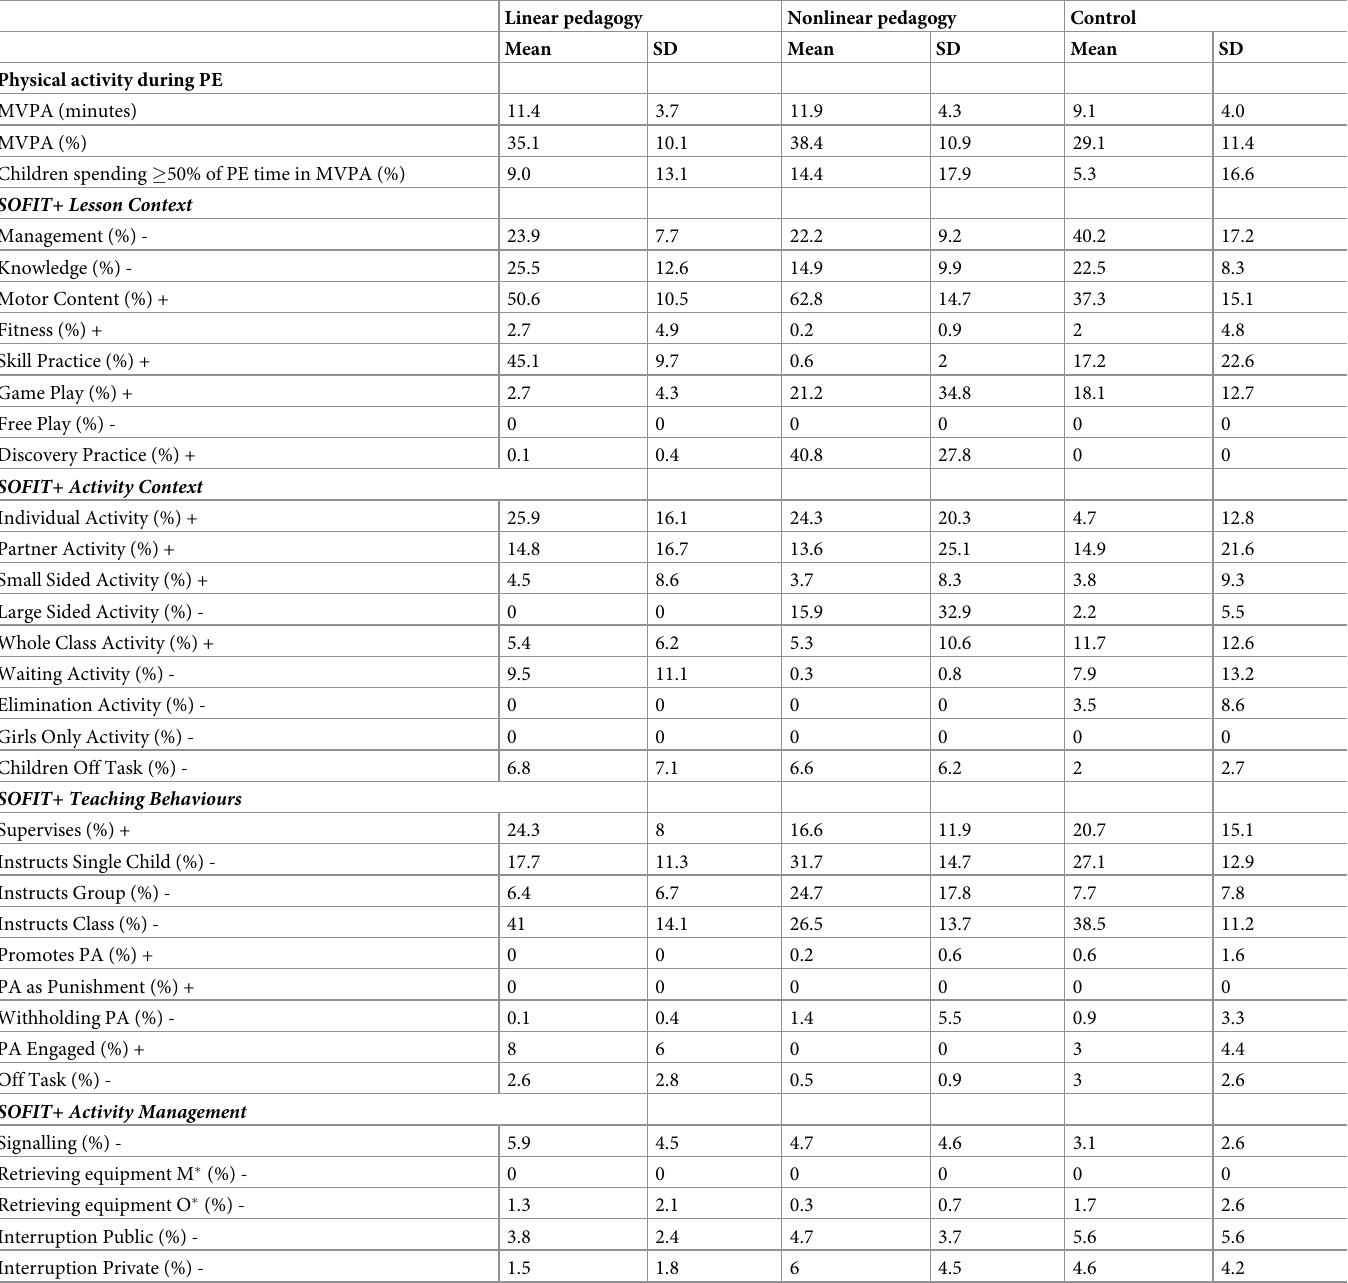
Table 3. Physical activity outcomes derived from accelerometers and teaching practices assessed using SOFIT+. Linear